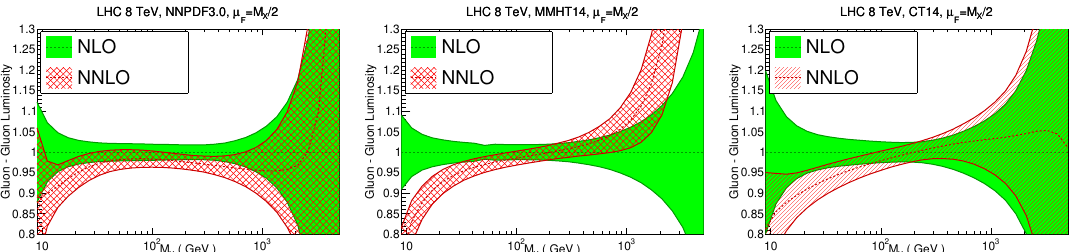
Figure 11 . LHC 8 TeV gg-luminosities for NNPDF3.0 (left), MMHT2014 (centre) and CT14 (right) as a function of the mass M X of a (cid:12)ctitious (cid:12)nal state gg ! X . For each plot, the PDF luminosities have been normalised to the central value of the NLO result. The factorisation scale is M X =